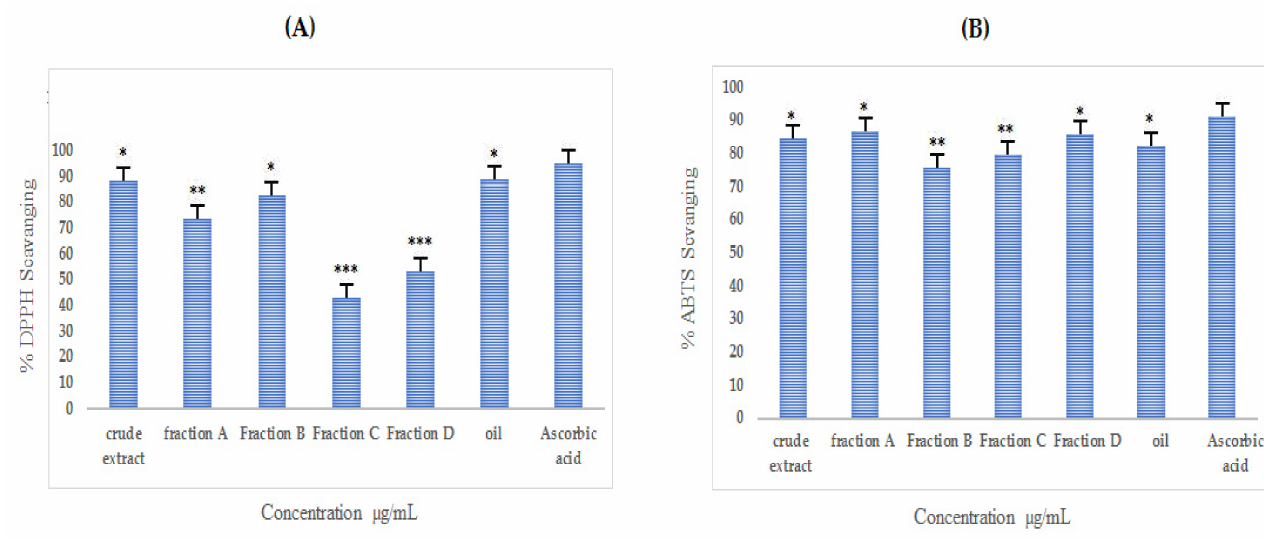
Figure 6. Antibacterial potential of crude extract, purified fractions (A, B, C, and D), and oil fraction of A. articulata against ( A ) E. coli , ( B ) Shigella dysentery and ( C ) S. typhi . The data are represented as mean ± SEM, n = 3. Values are significantly different as compared to positive control *** p < 0.001.